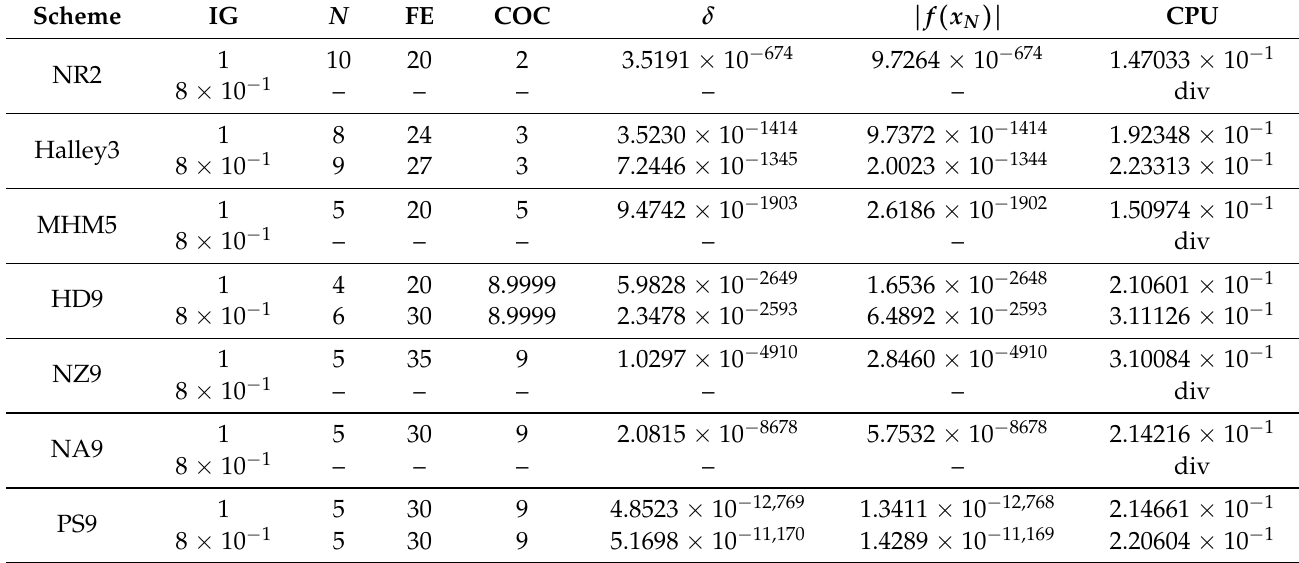
Table 7. Numerical results for problem 2 ( f 5 ( x )) with two different initial